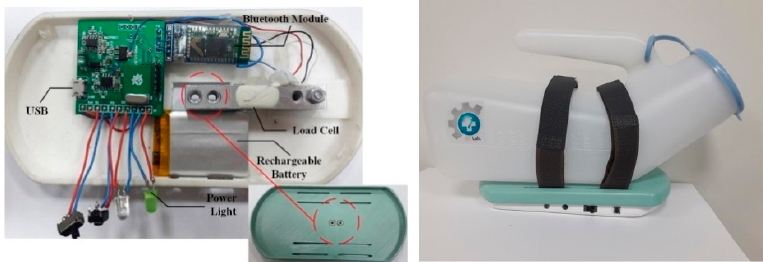
Figure 3. The measuring module of CIC assistant device exterior-view ( left ) and with container ( right ). Based on the study, the app recorded the user’s voided volume, the exact time of voiding, and the interval of the CIC. Alerts are given immediately when the result is abnormal, as shown in the following